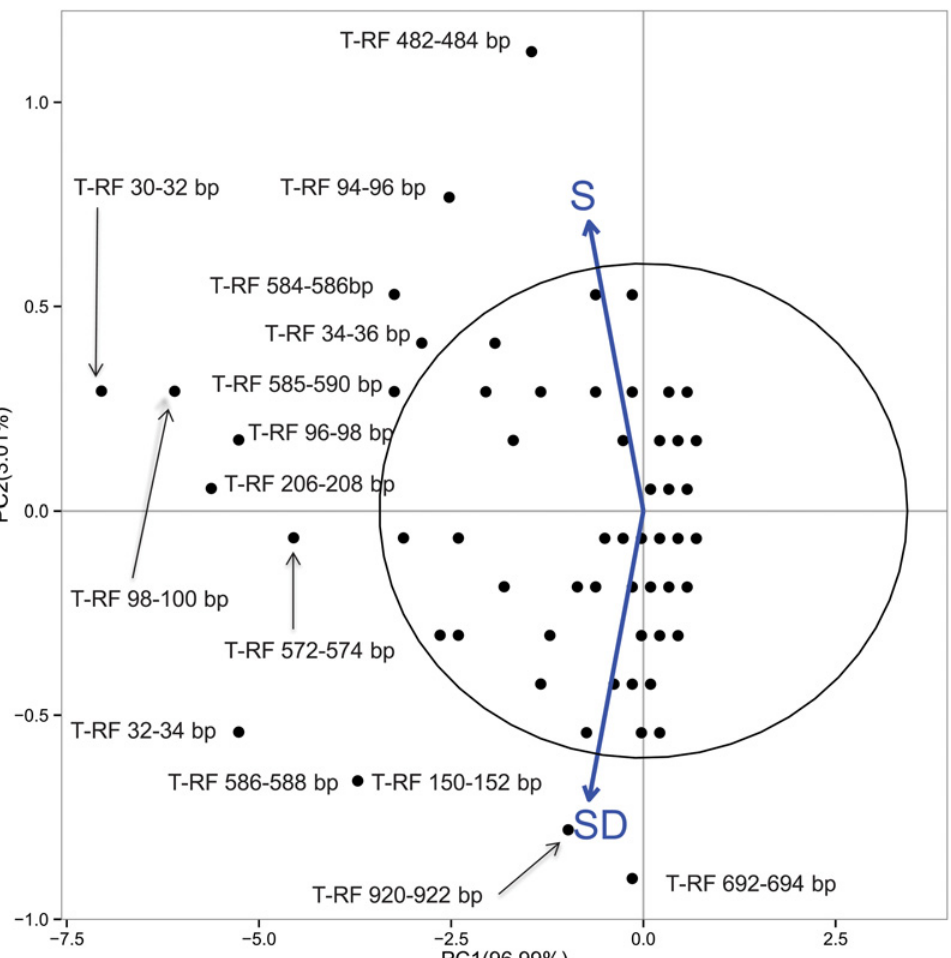
Fig 3. PCA of total occurrences of T-RFs in CF patients showing comparison of S with SD patients. Ellipse with 95% is reported. The numbers on the axes indicate the amount of variance explained by each component. The labels outside the 95% ellipse have been jittered to avoid overlaps. Black circles represent T-RFs. Are indicated those T-RFs, ouside the ellipse, that are significantly associated to the PC1 and PC2.